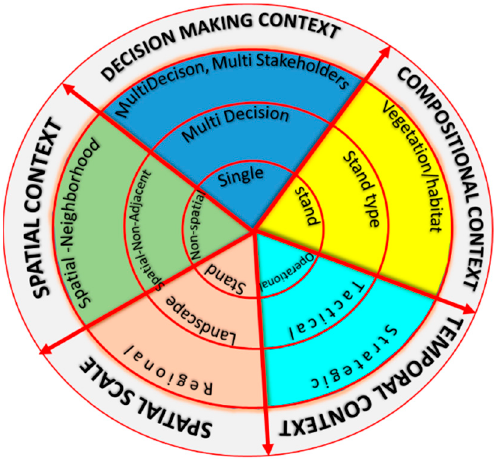
Figure 1. A contextual organization of basic components of the framework for addressing multiple ecosystem services in forest management planning.